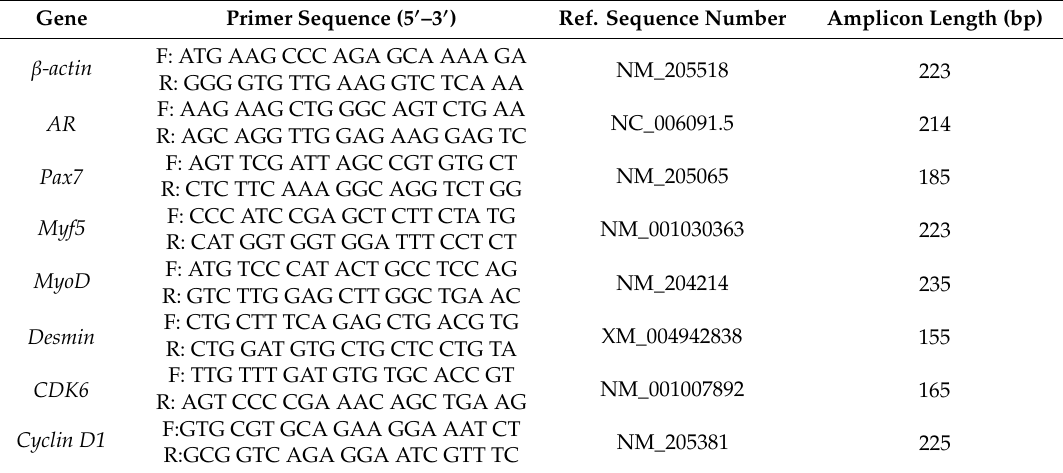
Table 1. Primer sequences for genes of PCR